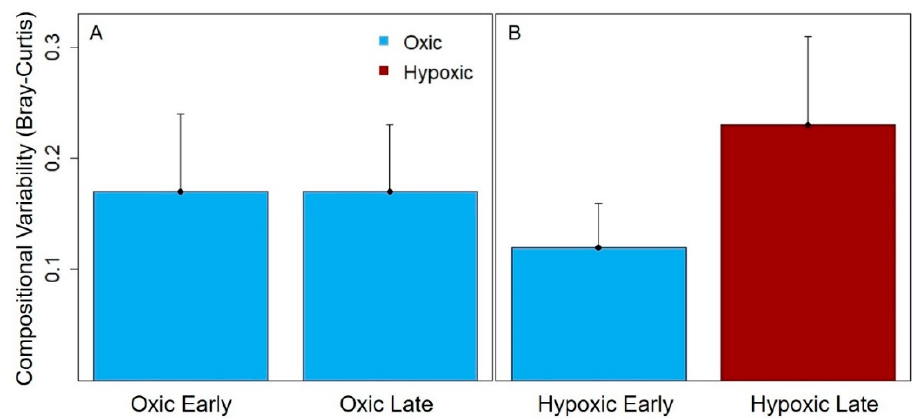
Figure 6. Mean (error bar is 1 standard deviation) compositional variability of crustacean zooplankton communities in the early and late stratified periods in the seasonally oxic reservoirs ( A ), and the oxic and hypoxic periods of the sampling season for the seasonally hypoxic reservoirs ( B ).